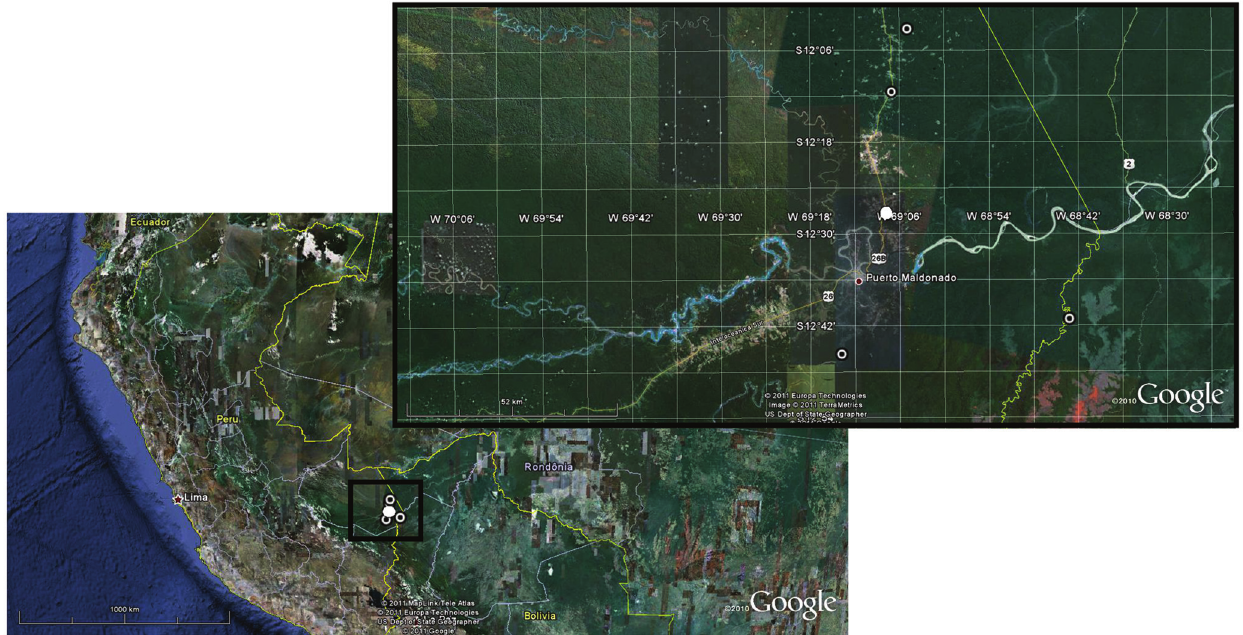
Fig. 8. Geographic distribution of Chrysobrycon eliasi . White circle indicates two localities, including type locality. The inset from upper part of figure is delimited by black line and correspond to a zoom of the rectangle indicate below it.